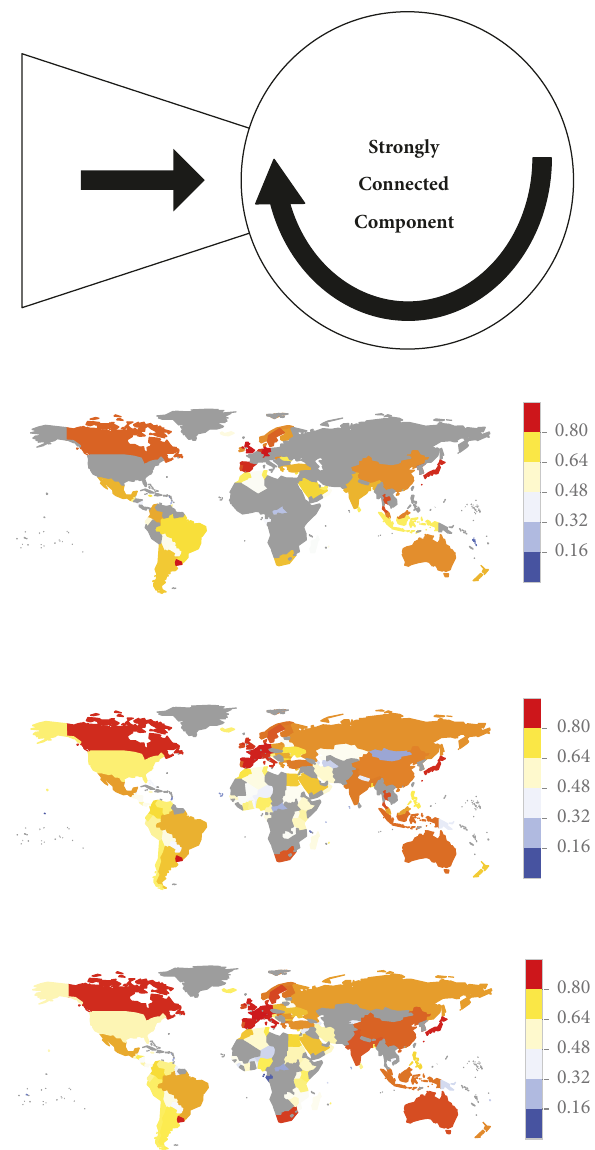
Figure 1: Top panel: the WTW bow-tie structure, composed by the SCC and the IN-component only. The panels below show the countries belonging to the SCC (in colors) and the countries belonging to the IN-component (in gray) in 1993, 1998 and 2002, respectively. Countries belonging to the SCC keep rising their reciprocated degree (see also Figure 2); richest world countries (Canada, Europe, Japan, in dark red) are always characterizedby the largest values of reciprocated